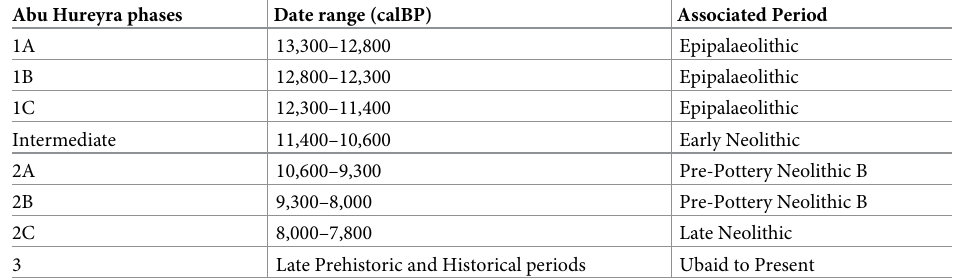
Table 1. Chronology of occupation at Abu Hureyra. Approximate date ranges reflect radiocarbon dates calibrated using IntCal20 [1,